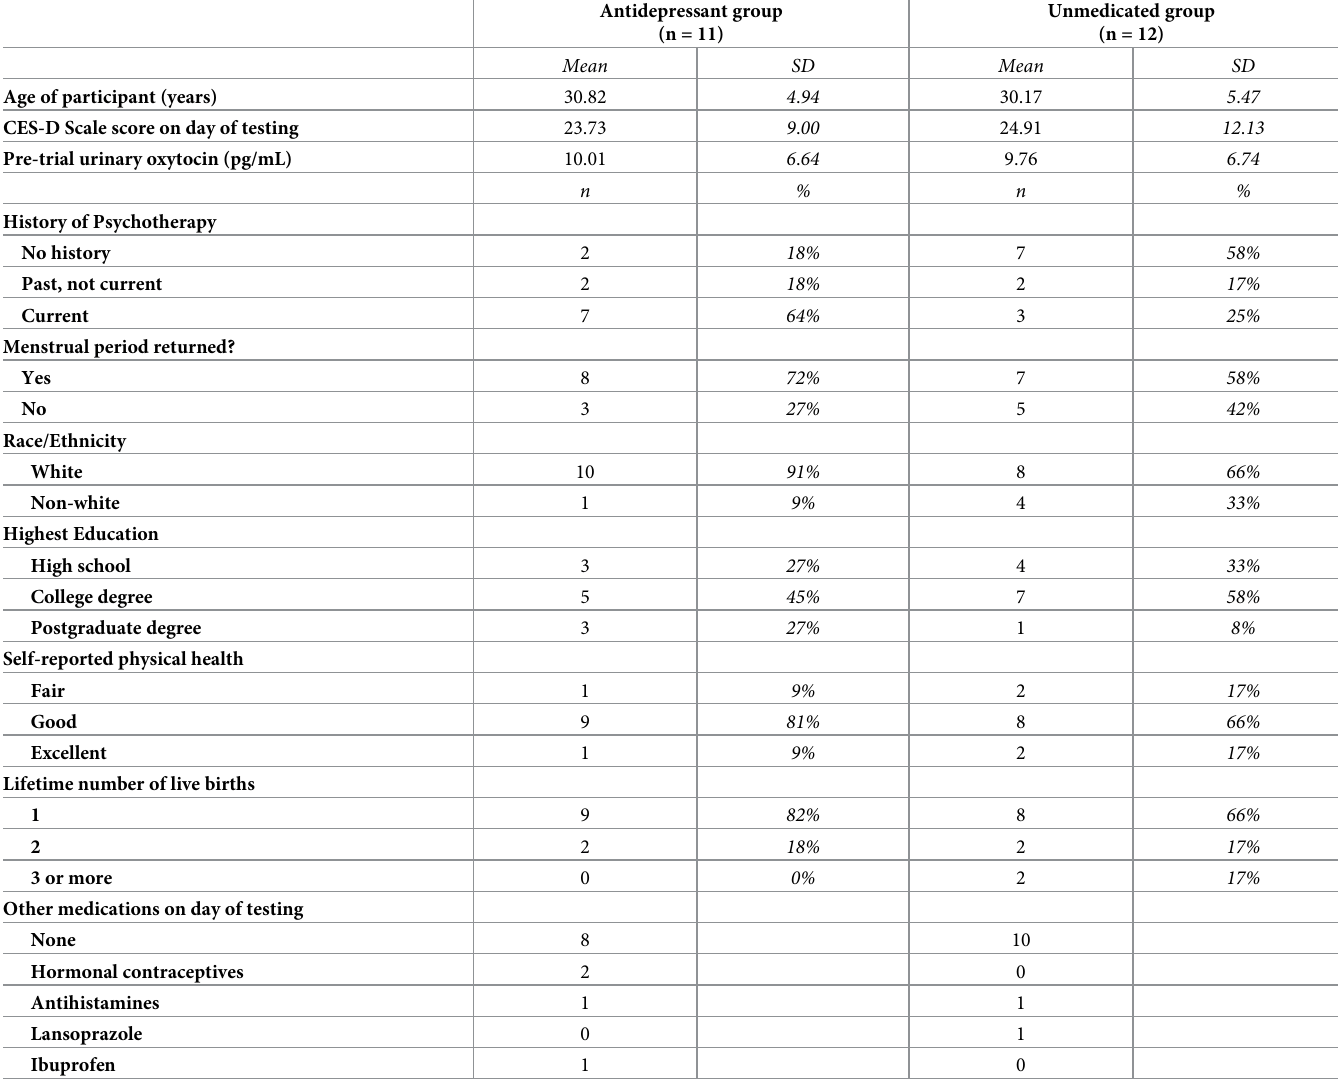
Table 1. Demographics. There were no significant differences in demographics across medication group. CESD: Center for Epidemiologic Study–Depression